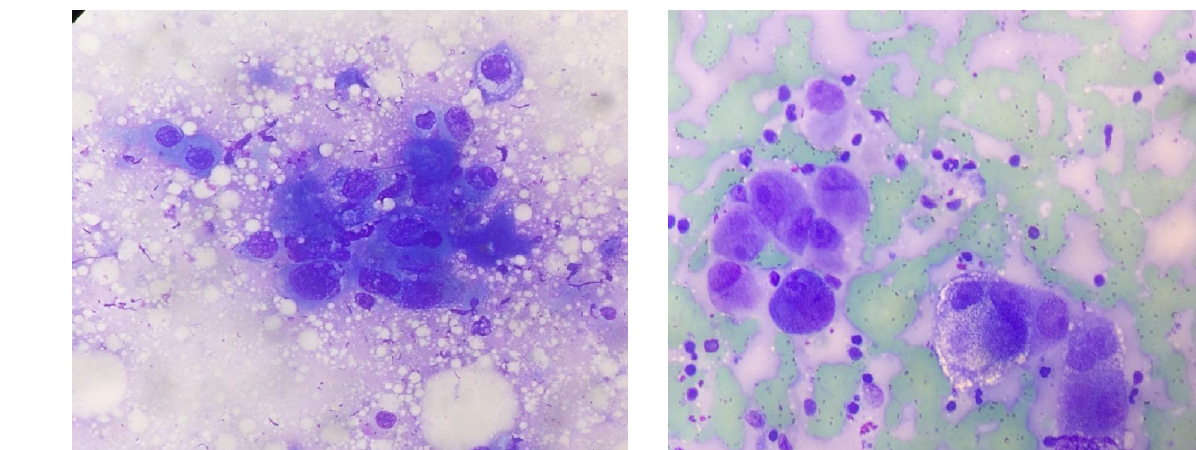
Fig 4: Smear showing malignant cluster of metastatic adenocarcinoma.